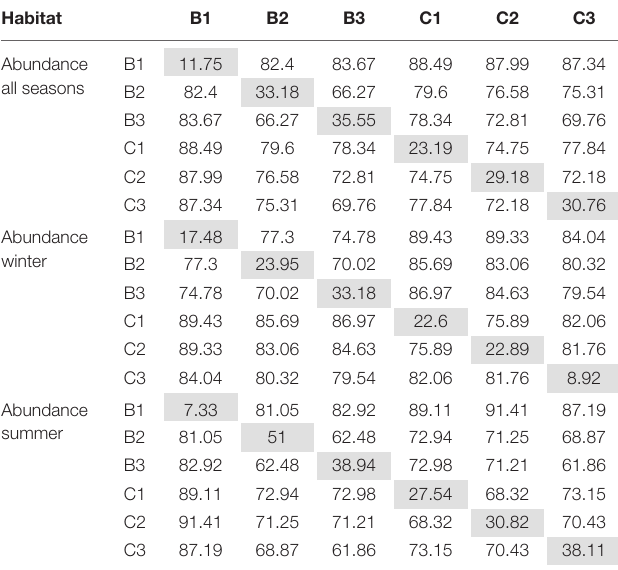
TABLE 4 | Based on community abundance data, the SIMPER analyses present similarities within habitats (gray cells) as well as dissimilarities between habitats for benthic community composition during all seasons, winter and summer.